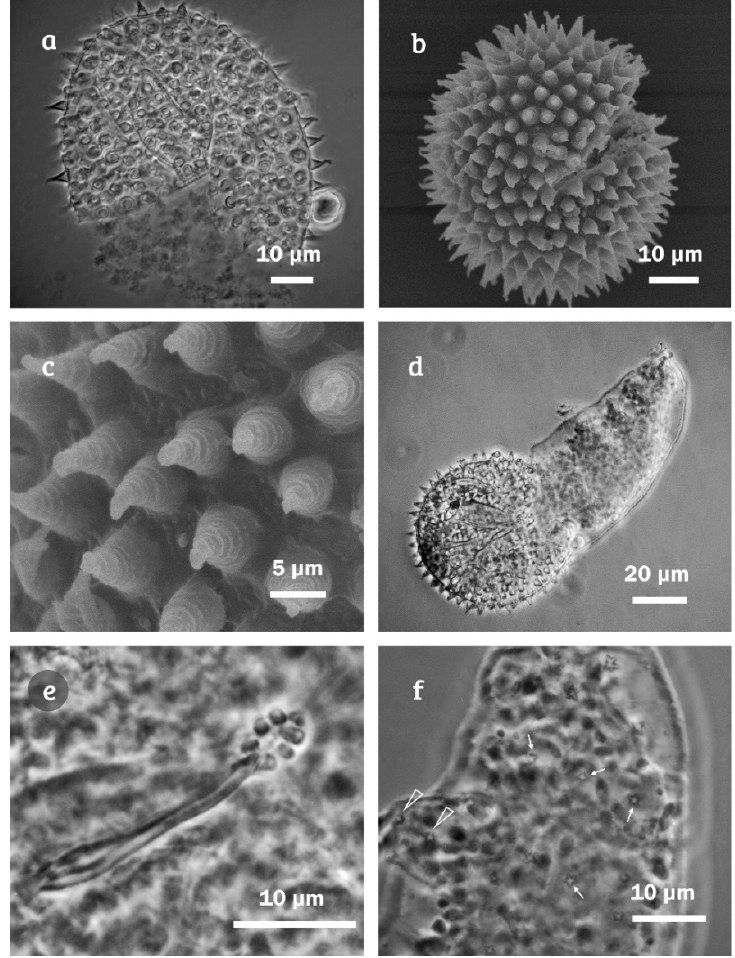
Figure 8. Minibiotus citlalium sp. nov. eggs: ( a ) egg surface (PCM); ( b ) egg surface (SEM); ( c ) egg processes showing four annulations (SEM); ( d ) hatching specimen (PCM); ( e ) detail of the embryo showing buccal apparatus; and ( f ) detail of cuticle of hatching specimen, arrows indicates a star-shaped pores, a pair of star-shaped pores, one of them conspicuously larger. Table 4. Measurements [in μ m] of selected morphological structures of eggs of Minibiotus citlalium sp. nov. mounted in polivinil lactofenol medium (N—number of eggs/structures measured, RANGE—refers to smallest and largest structure among all measured specimens; and SD—standard deviation) .